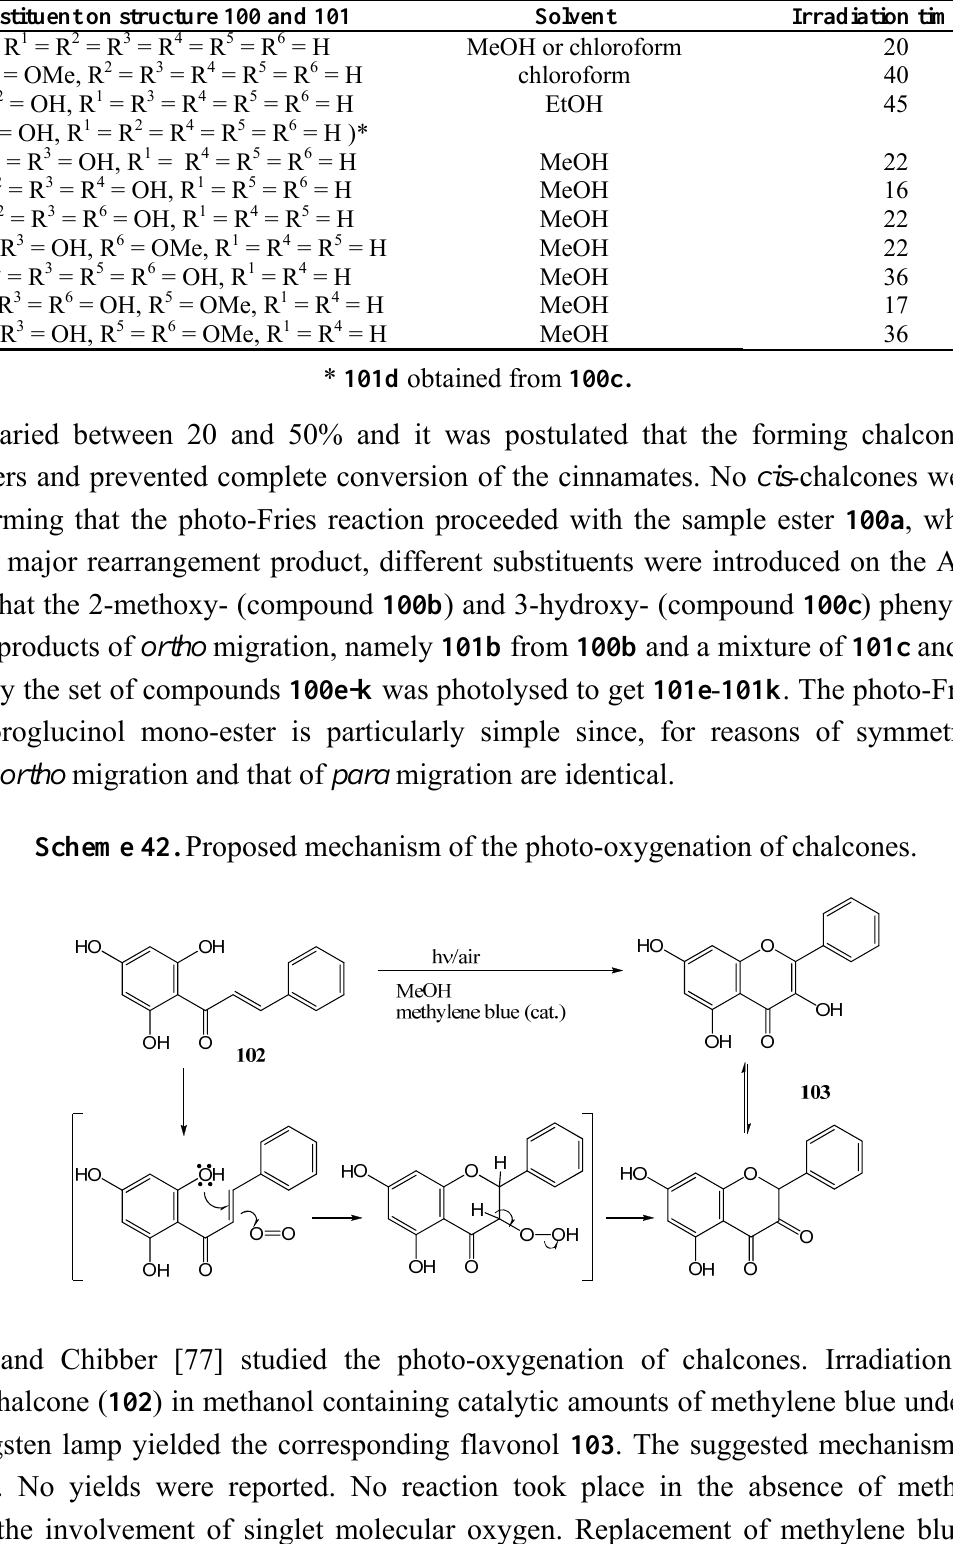
Table 12. R 1 - R 6 substituents on structure ( 100 ) and ( 101 ). Substituent on structure 100 and